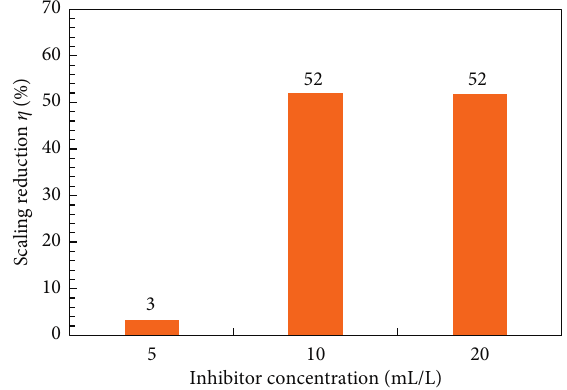
Figure 4: Scale inhibition efficiency titration test.